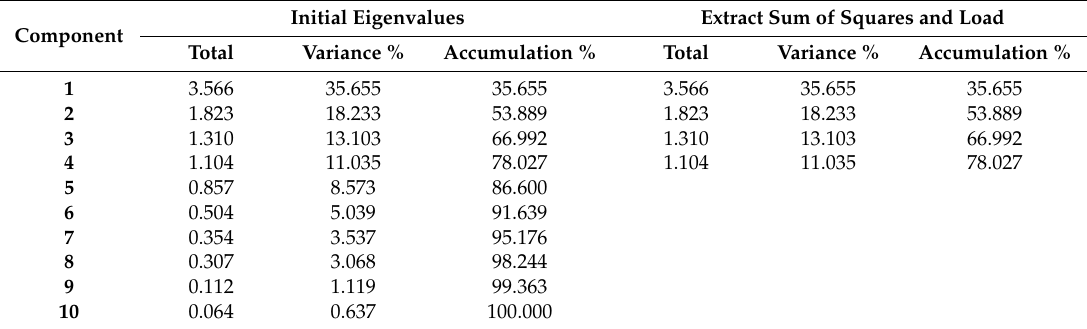
Table 6. Variance decomposition of the extracted principal components of water quality indexes.